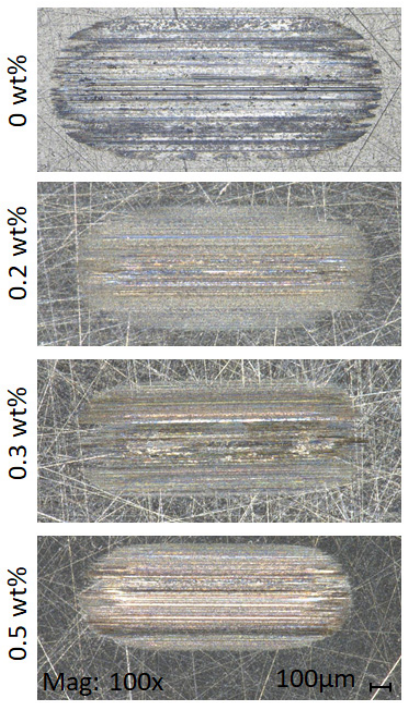
Figure 3. Digital microscope images about the worn sur- faces of the disc specimens with different CuO-concen- trations